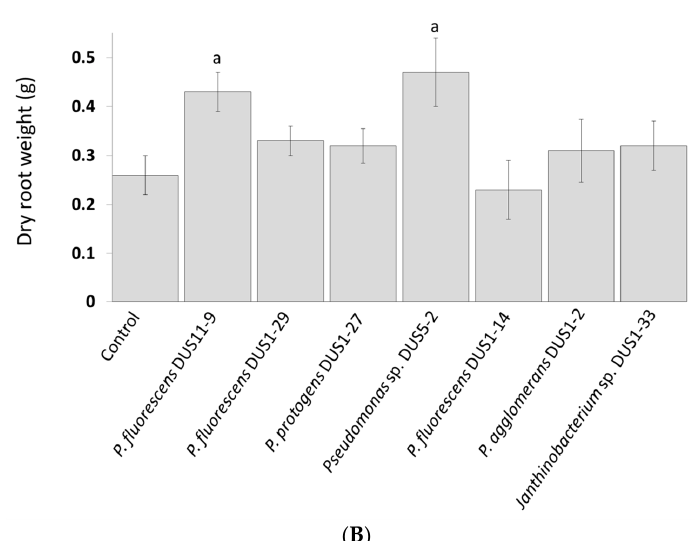
Figure 4. Effect of bacterial isolates on plant shoot ( A ) and root ( B ) biomass after 91 days in a glasshouse system with media (soil) maintained at 8% water activity. For inoculated plants, 1 × 10 3 CFU of each strain were added when seeds were sown. Five biological replicates (five pots) with five technical replicates (five plants per pot) were set up and grown for 91 days for each treatment group. Significantly ( p < 0.05) increased dry shoot ( A ) and dry root ( B ) biomass of inoculated plants compared to uninoculated control plants are denoted by the letter “a”.